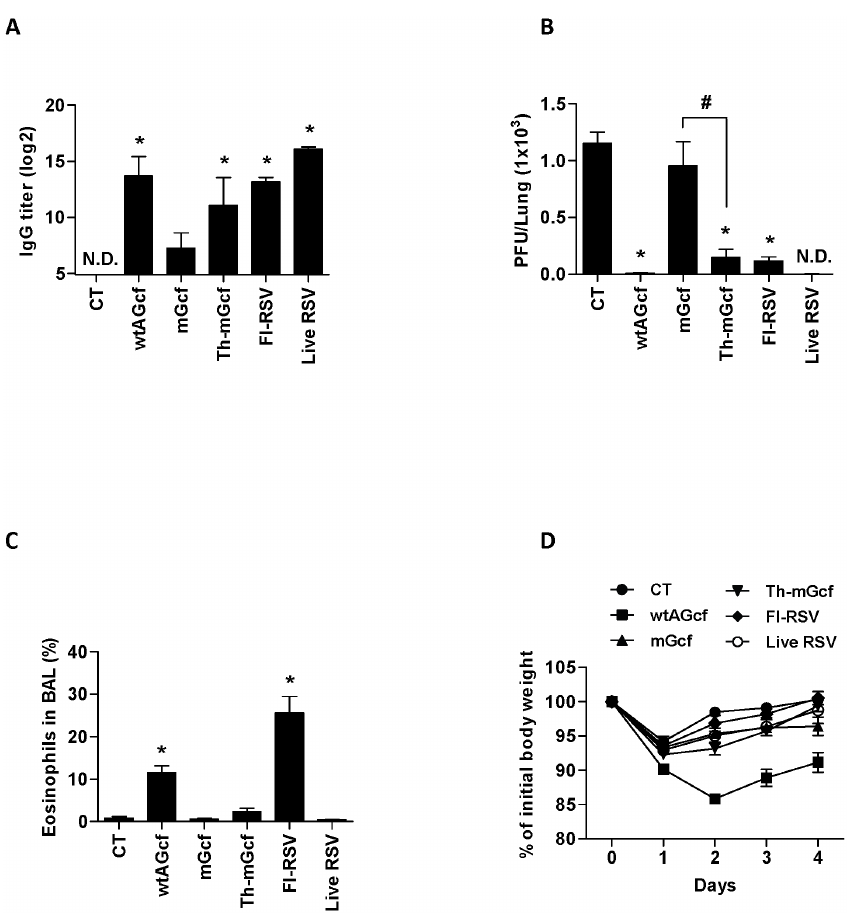
Figure 6. Effect of modified Gcf on the infection of homologous RSV A type. Mice (n=5) were immunized with 20 m g of wtAGcf, mGcf, or Th-mGcf sublingually in the presence of 2 m g of CT, 1 6 10 5 PFU of FI-RSV through foot-pad or 1 6 10 5 PFU of live RSV A2 intranasally on days 0 and 14 and (A) RSV A2 specific serum IgG was measured by ELISA two weeks after the second immunization. The mice were challenged with 2 6 10 6 PFU of RSV A2 three weeks after the last immunization. (B) The viral replication in the lungs was determined by plaque assay at day 4 post-challenge and (C) the pulmonary eosinophils were examined by flow cytometry. (D) The body weight loss was monitored daily after the viral challenge. N.D., not detected. The results are expressed as means + S.E.M. for the group (n=5). The data are representative of three separate experiments. Significant differences from results with the CT are marked with asterisks (*), while significant differences between mGcf and Th-mGcf are marked with sharp ( # ) respectively (* or # , P , 0.05)